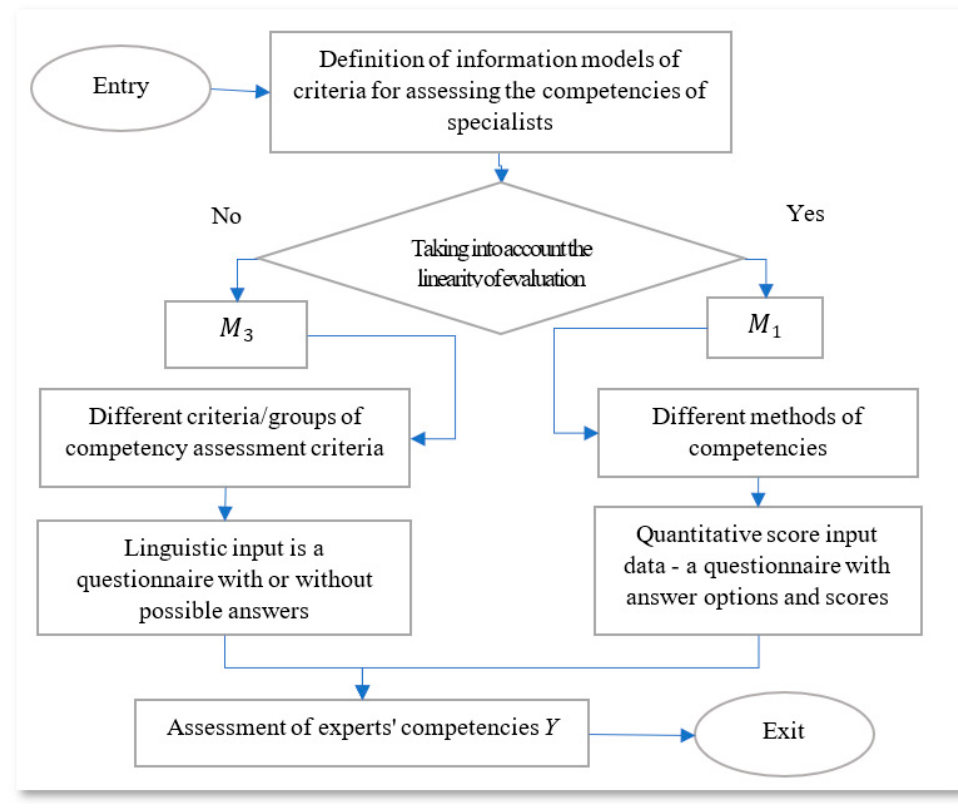
Figure 1. Algorithm for choosing a model for assessing the competencies of smart city specialists, taking into account the linearity of assessment processes: M 1 —fuzzy model for assessment of the competence of specialists; M 3 —neuro-fuzzy network.